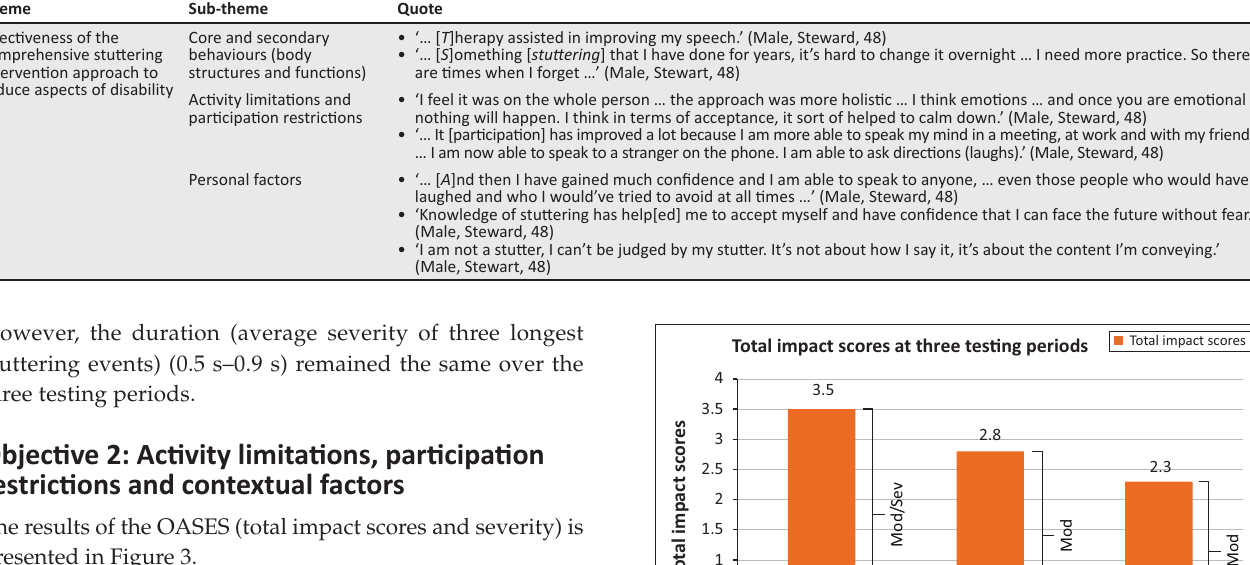
TABLE 2: Themes with their respective quotes from the participant on the influence of the comprehensive stuttering approach. Theme Sub-theme Quote Effectiveness of the comprehensive stuttering intervention approach to reduce aspects of disability